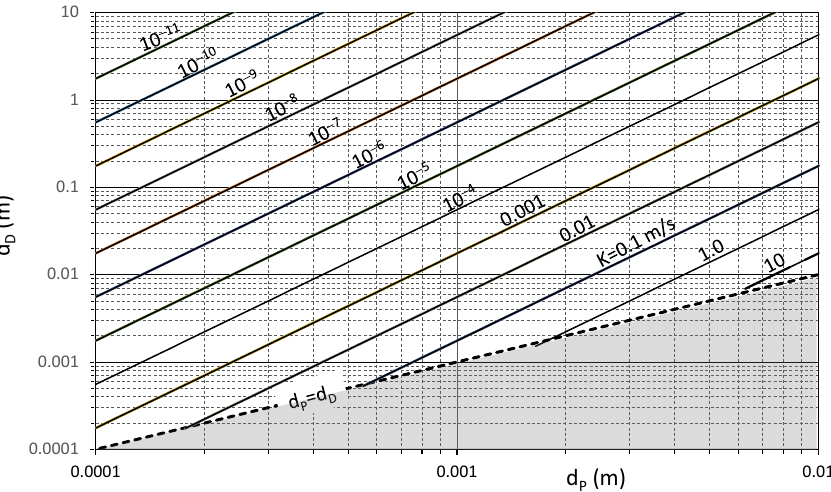
Figure 3. Relationship between the Poiseuille and Darcy laws; d P , tube diameter of Poiseuille reservoir; d D , tube diameter of Darcy reservoir; K , hydraulic conductivity of sand filling the tube of Darcy reservoir. In the grey field ( d P ≥ d D ) no-relationship